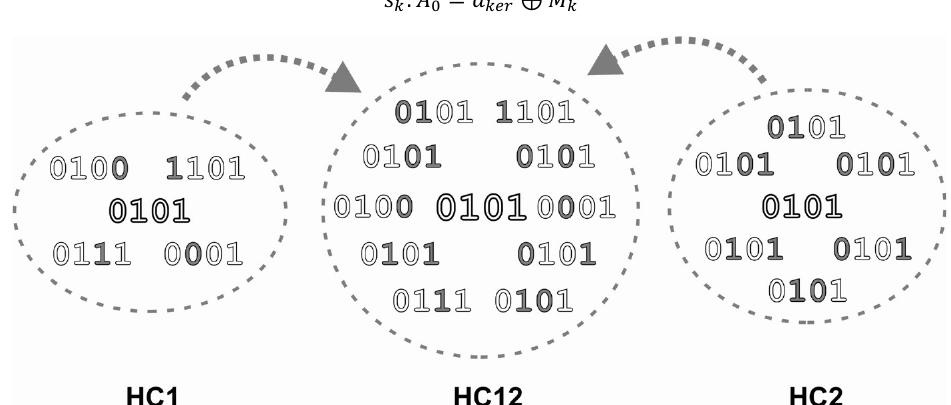
Fig. 2 . An example of neighbourhood generation for 4-bit binary string using transformations H = { s 0 ,s 1 ,s 2 } and matrixes M 0 ,M 1 ,M 2 , i.e. utilization in algorithms HC1, HC2 and their union HC12